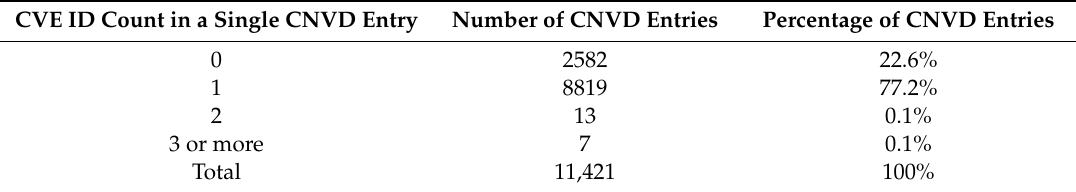
Table 5. Number of referenced CVE IDs per CNVD